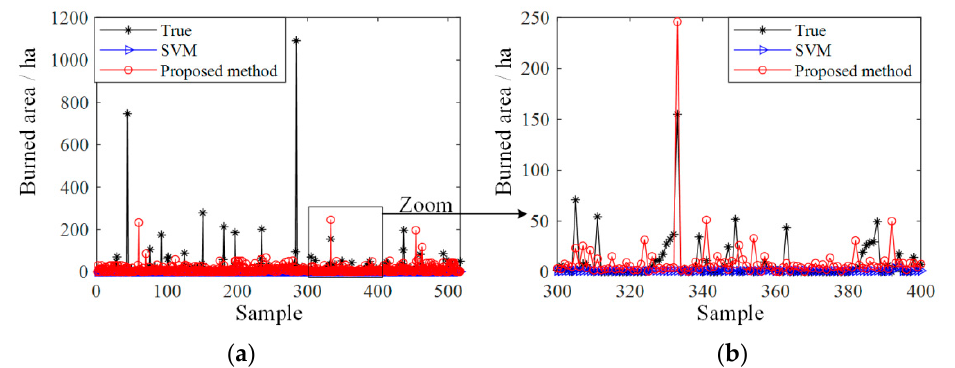
Figure 6. An example of prediction results: ( a ) obtained from one fold of cross-validation; ( b ) local zoom.